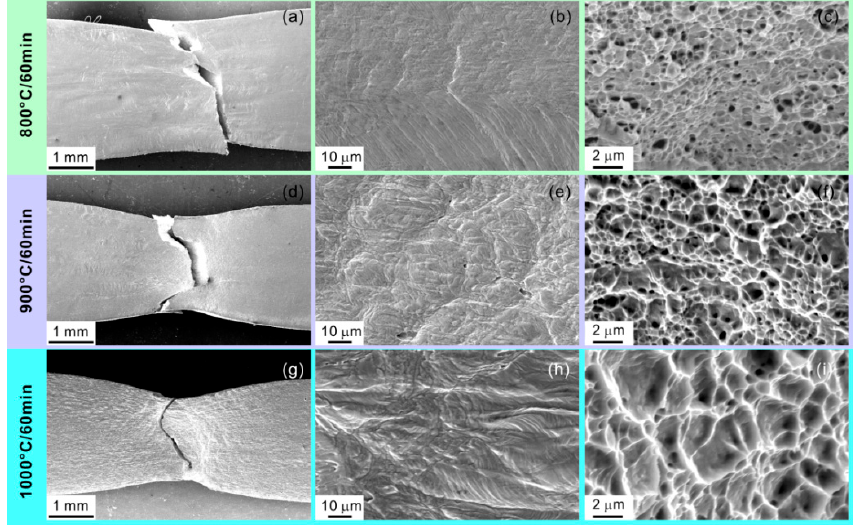
Figure 13. SEM images of surface damage and fracture surface features in ( a – c ) 800 °C-, ( d – f ) 900 °C-, and ( g – i ) 1000 °C-annealed HEA specimens.